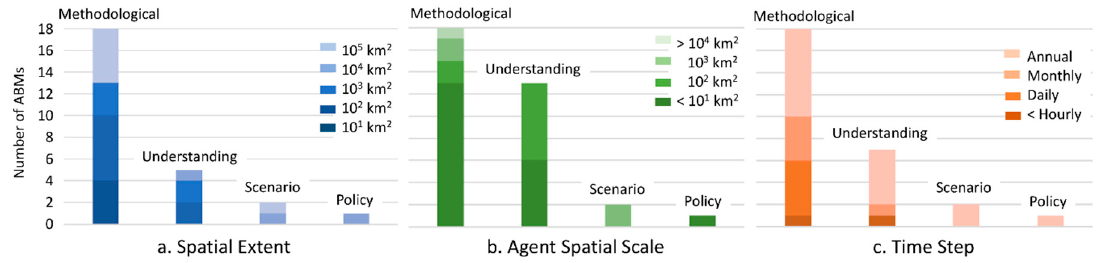
Figure 4. Relationships among the review models’ primary purpose (methodological, system understanding, scenario assessment, and inform policy) and design choices for models’ ( a ) spatial extent, ( b ) spatial scale of decision-making entities (i.e., agents), and ( c ) simulation time step.